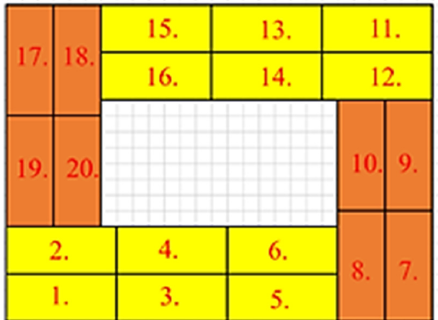
Figure 17. The order of the object arrangement.